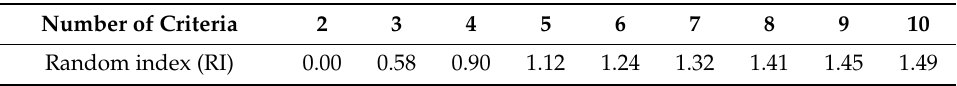
Table 3. Random consistency Index